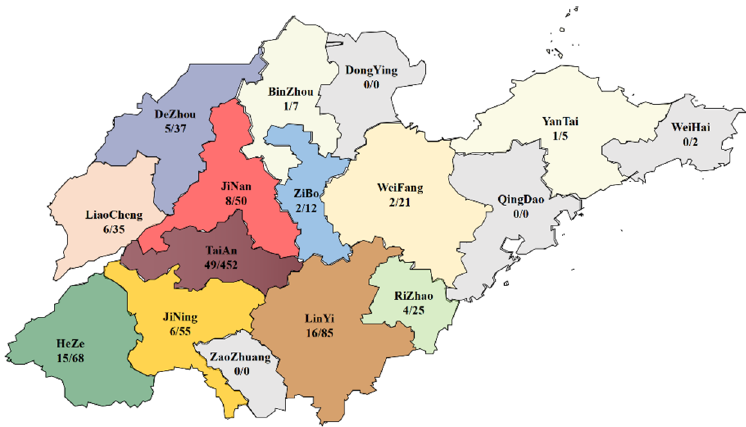
Figure 1. Map of CAV-positive samples distribution in Shandong Province from 2020 to 2022.